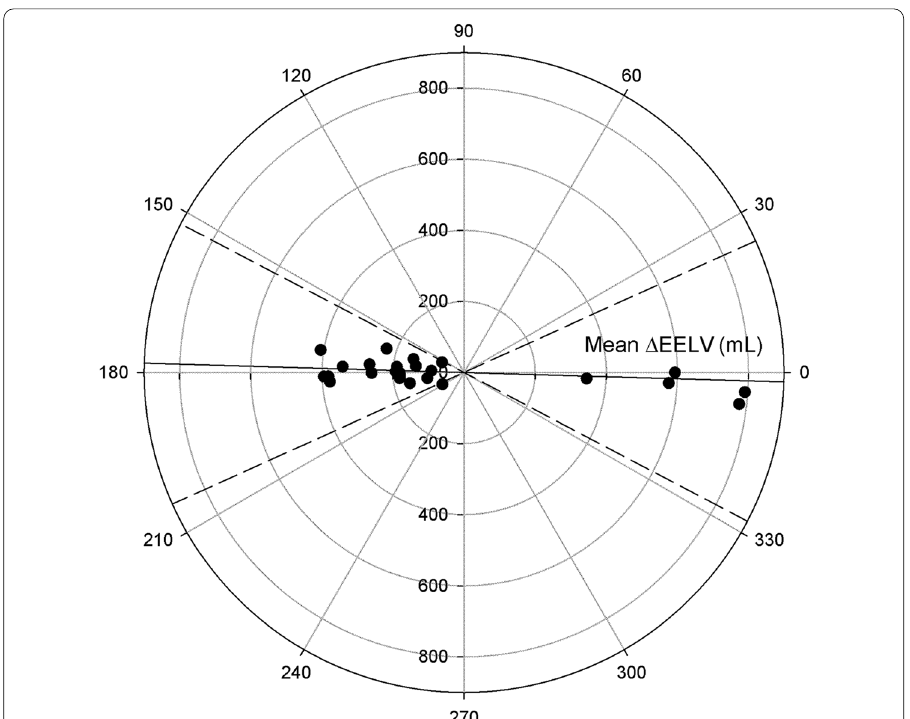
Fig. 4 Polar plot assessing trending ability of EELV MBNW to track changes in EELV CT . The radial axis joining 0 to 180° is a 45° clockwise rotation of the line of identity in the four‑quadrant plot and represents perfect agreement. The better the agreement between ΔEELV measurements, the closer data pairs will lie along the horizontal radial axis. The distance from the center of each plot represents the mean change in EELV between methods (mean ΔEELV) at each consecutive time points. Data points located between 315 and 45° refer to time points in which both EELV CT and EELV MBNW increased (upper right quadrant of the four‑quadrant plot), while data points located between 135 and 225° refer to consecutive time points in which both EELV CT and EELV MBNW decreased (lower left quadrant of the four‑quadrant plot). Data points located between 45 and 135° or 225 and 315° correspond to disagreement in the directional change of EELV between both techniques. Continuous line represents angular bias, while dashed lines represent radial limits of agreement. EELV MBNW end‑expiratory lung volume assessed with the multiple breath nitrogen washin–washout = technique; EELV CT end‑expiratory lung volume assessed by computed tomography; ΔEELV = EELV between consecutive